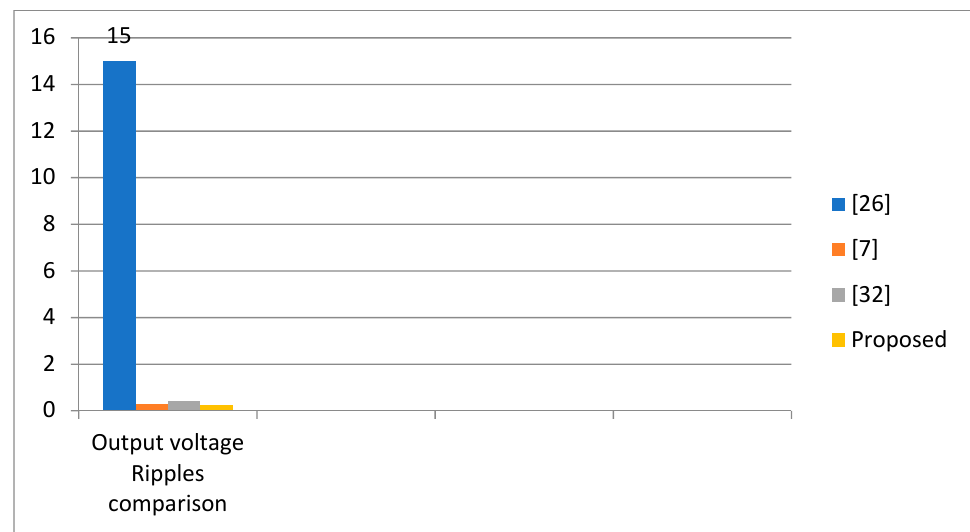
Figure 36. Voltage ripples magnitude comparison.